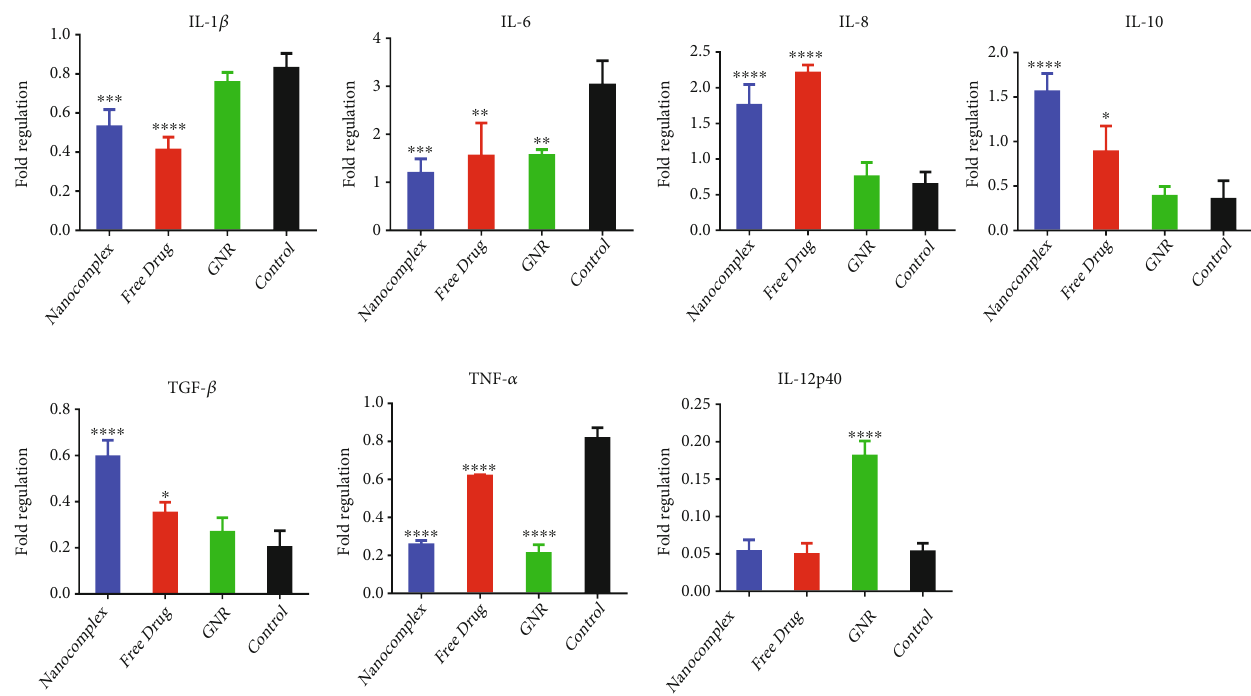
Figure 3: Measurement of the gene expression level of cytokines secreted by macrophages treated with the following: nanocomplex (a drug- conjugated gold nanorods), the free drug (phosphatidylinositol 3-kinase (PI3K α ) inhibitor) and GNR; cholesterol-coated gold nanorods, and compared to the control untreated cells by qPCR.